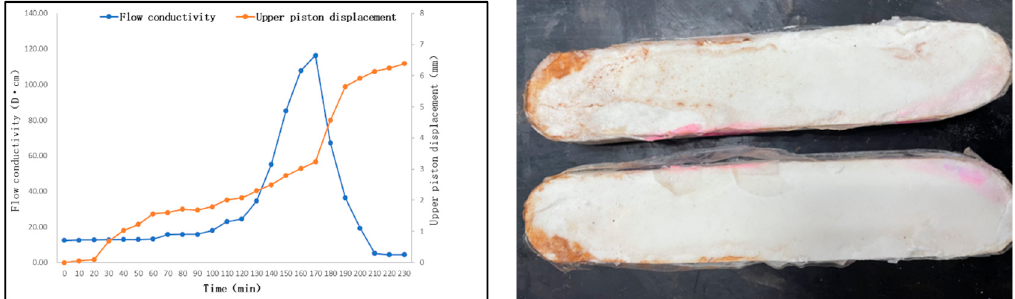
Figure 12. Variation curve of clearwater fracturing fluid conductivity and dissolution pattern of the rock slab.